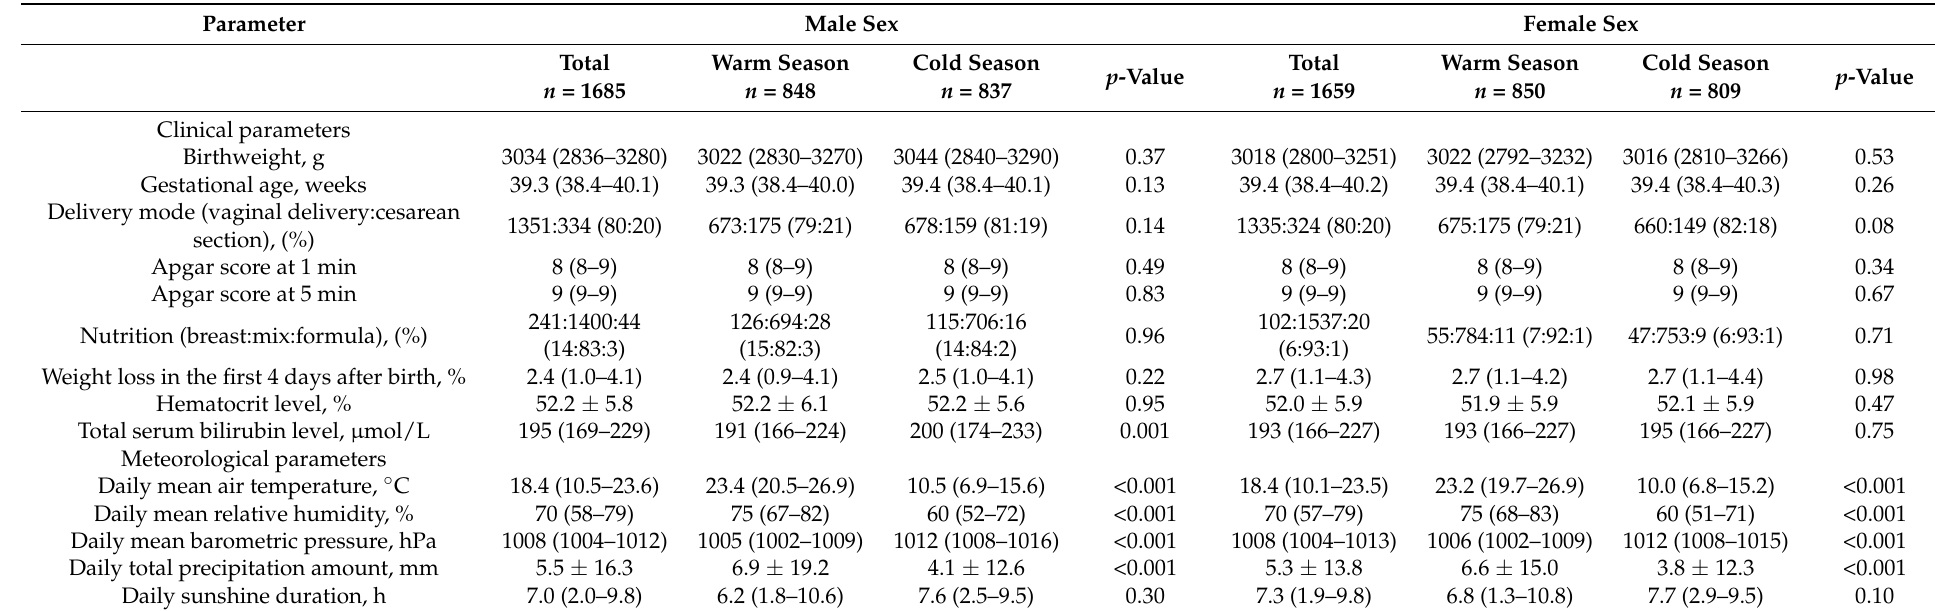
Table 2. Seasonal differences in the characteristics of the study population and meteorological parameters according to